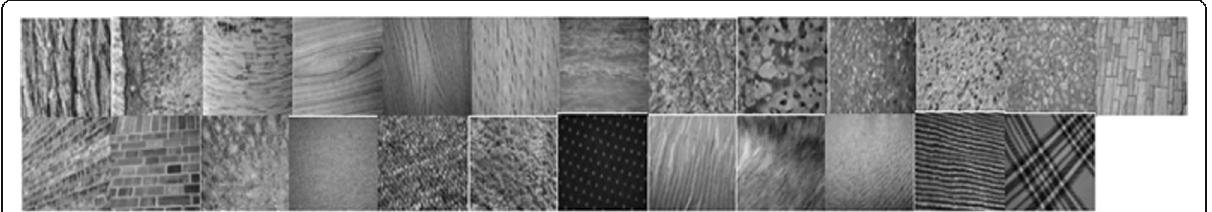
Fig. 14 Sample images of each texture class from UIUC